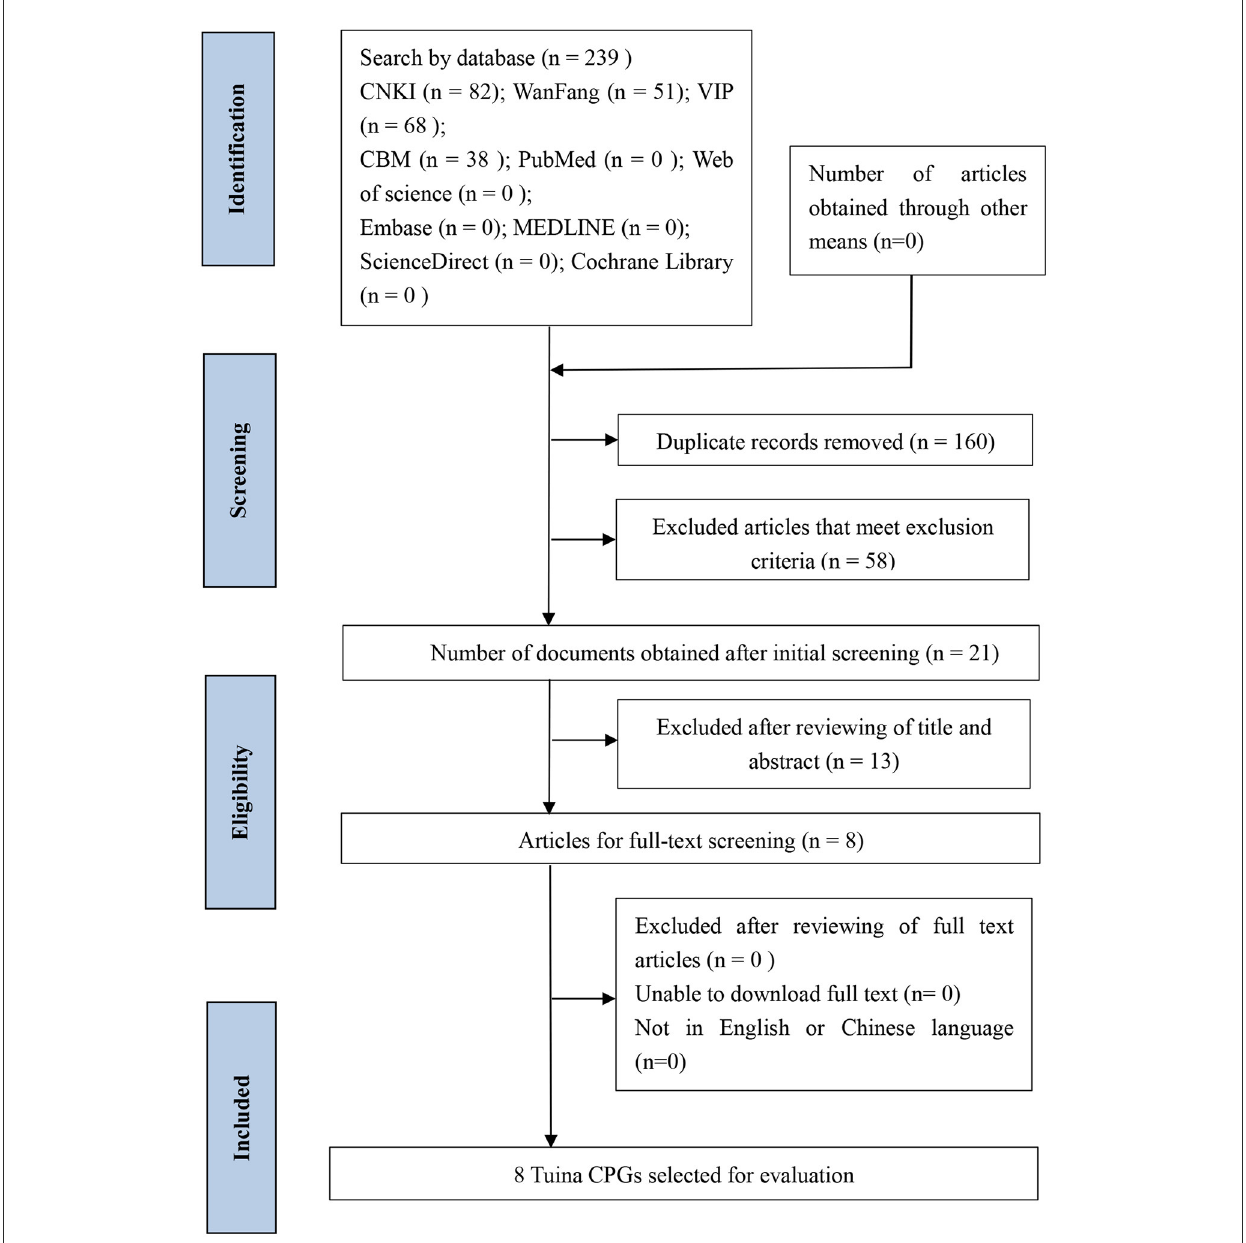
FIGURE1 Flowchart of Tuina guidelines searching and